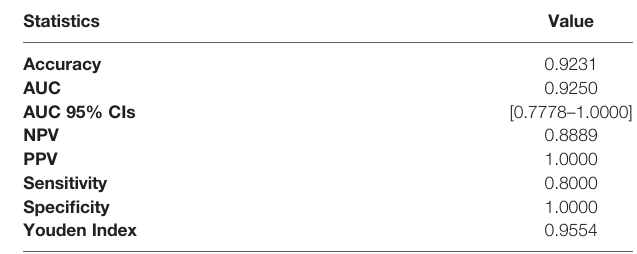
TABLE 5 | ROC analysis of ADC radiomics parameters.